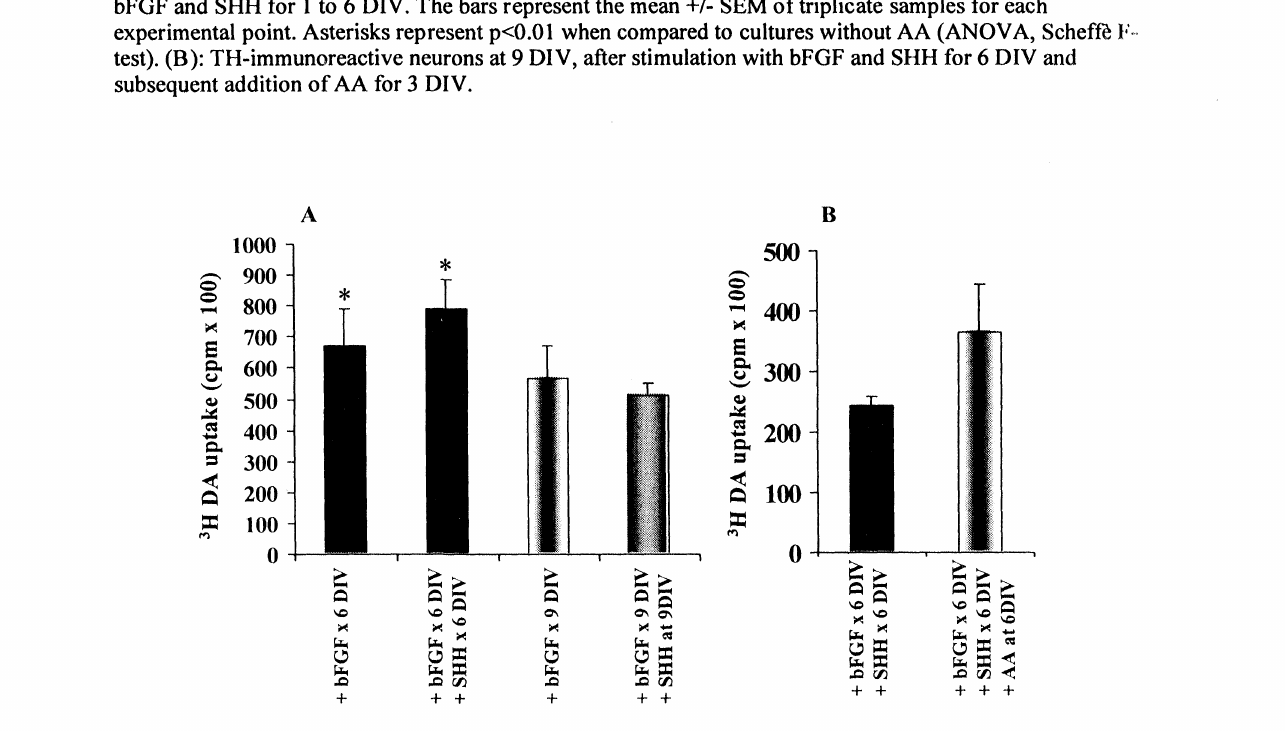
Fig. 6: [3H]-dopamine uptake in expanded MES cultures. (A): [3H]-dopamine uptake at 12 DIV in expanded MES culture treated with bFGF for the first 6 DIV, or bFGF and SHH for the first 6 DIV, or bFGF for 9 DIV, or bFGF for 9 DIV and addition of SHH at 9 DIV. The bars represent the mean +/- SEM of triplicate samples for each experimental point. Asterisks represent p<0.01 when compared to cultures in presence ofbFGF for 9 DIV (ANOVA, Scheff F-test). (B): [3H]-dopamine uptake at 9 DIV in expanded MES cultures treated with bFGF and SHH for the first 6 DIV and subsequent administration of AA for 3